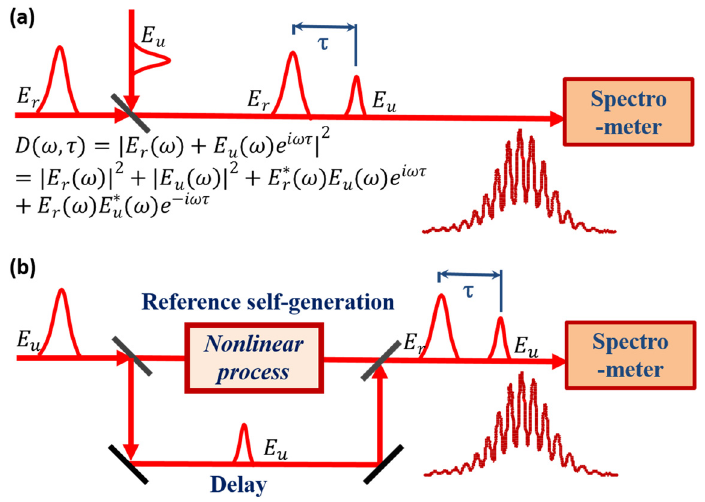
Figure 1. Principles of ( a ) spectral interferometry (SI) and ( b ) self-referenced spectral interferometry (SRSI), in which a nonlinear process is used to generate a reference pulse.